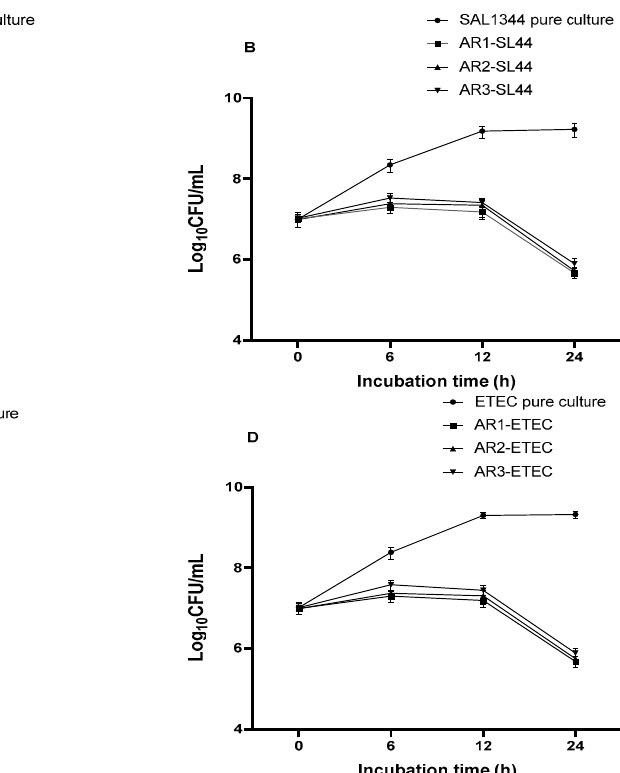
Figure 8. pH decline patterns of pure cultures of L. acidophilus AR1 and different pathogens, and co- cultures of L. acidoph- ilus AR1 with S . Typhimurium ATCC14028 ( A ), S . Typhimurium SL1344 ( B ), S. aureus ( C ), and ETEC ( D ).